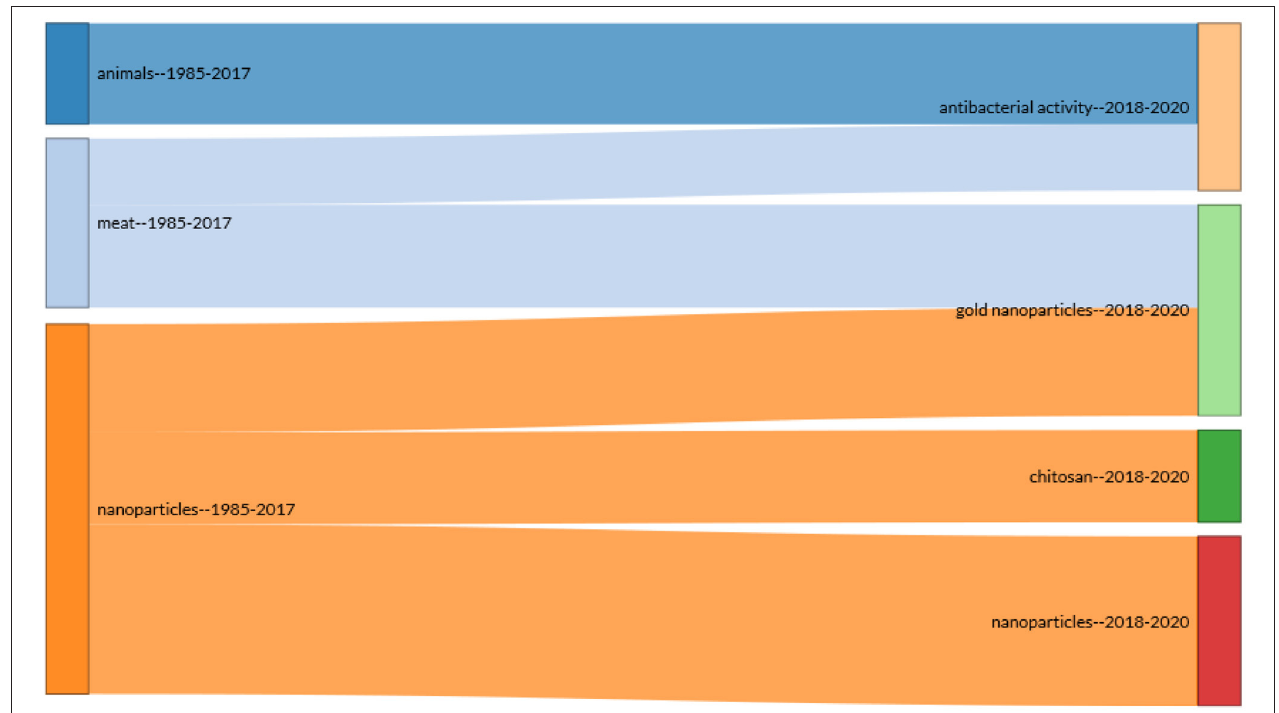
FIGURE 8 | Thematic evolution of author keywords on nanotechnology and meat production research from 1985 to